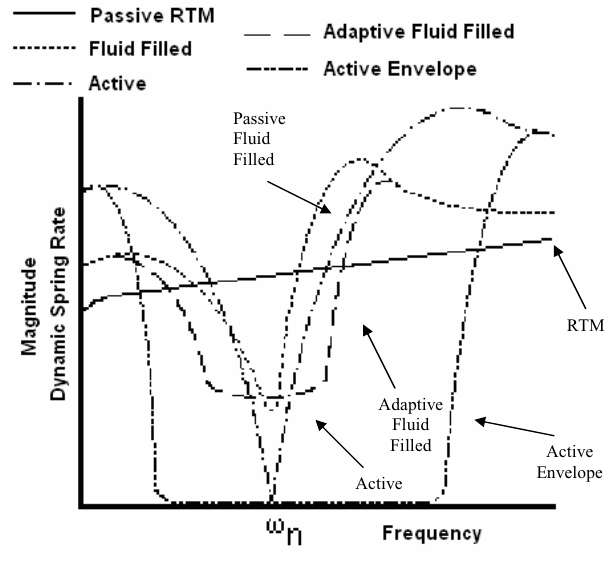
Fig. 6. Dynamic stiffness for various vibration